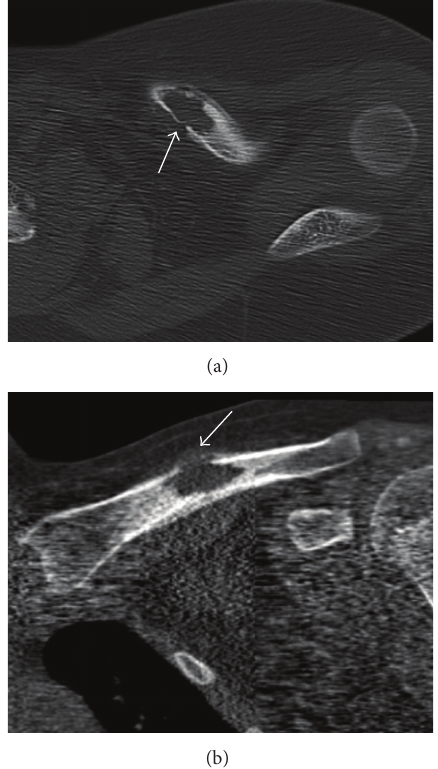
Figure 3: Axial (a) and coronal (b) reformatted CT images in bone window show the lytic mid-clavicle lesion with periosteal reaction and irregular cortical disruption (arrow). No soft tissue mass or marginal sclerosis is detected.